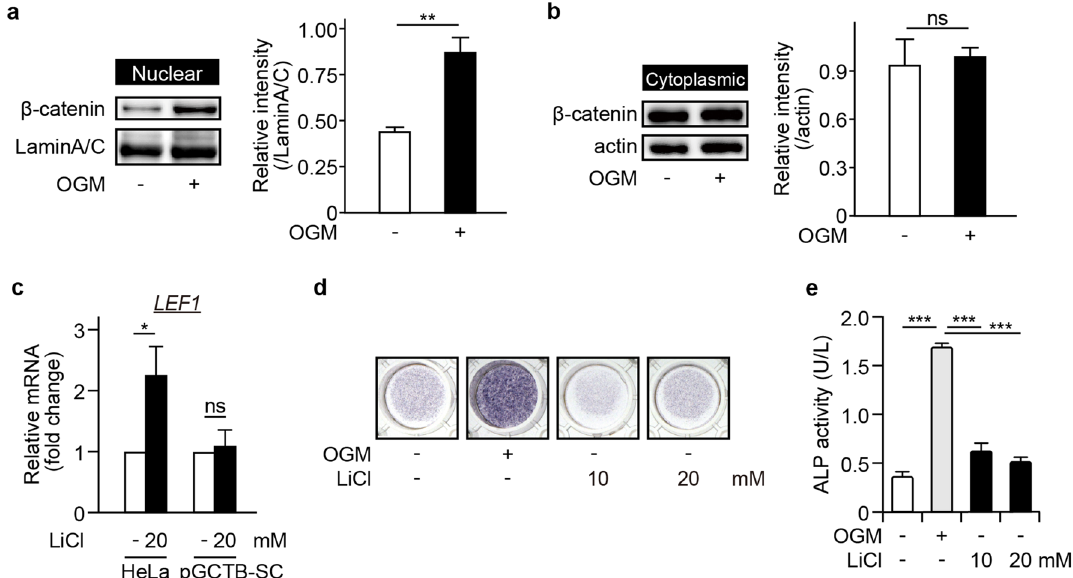
Figure 2. Nuclear β-catenin translocation (nuclear β-catenin translocation) is essential but not sufficient for bone differentiation of GCTB. ( a , b ) Induction of bone differentiation increased nuclear β-catenin translocation. pGCTB-SCs were treated with or without OGM for 12 h, and β-catenin was analyzed in the nuclear ( a ) and cytoplasmic ( b ) fractions by western blotting. Lamin A/C was adopted as a loading control for nuclear